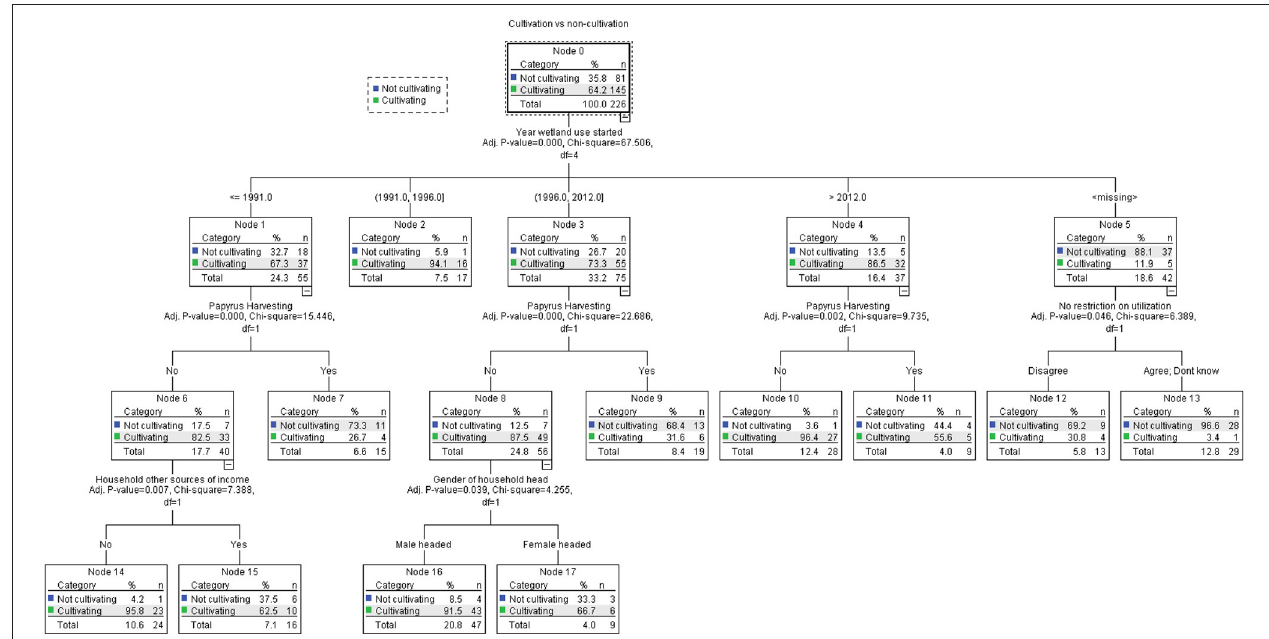
FIGURE 5 | Decision tree analysis on determinants influencing wetland utilization for agriculture.